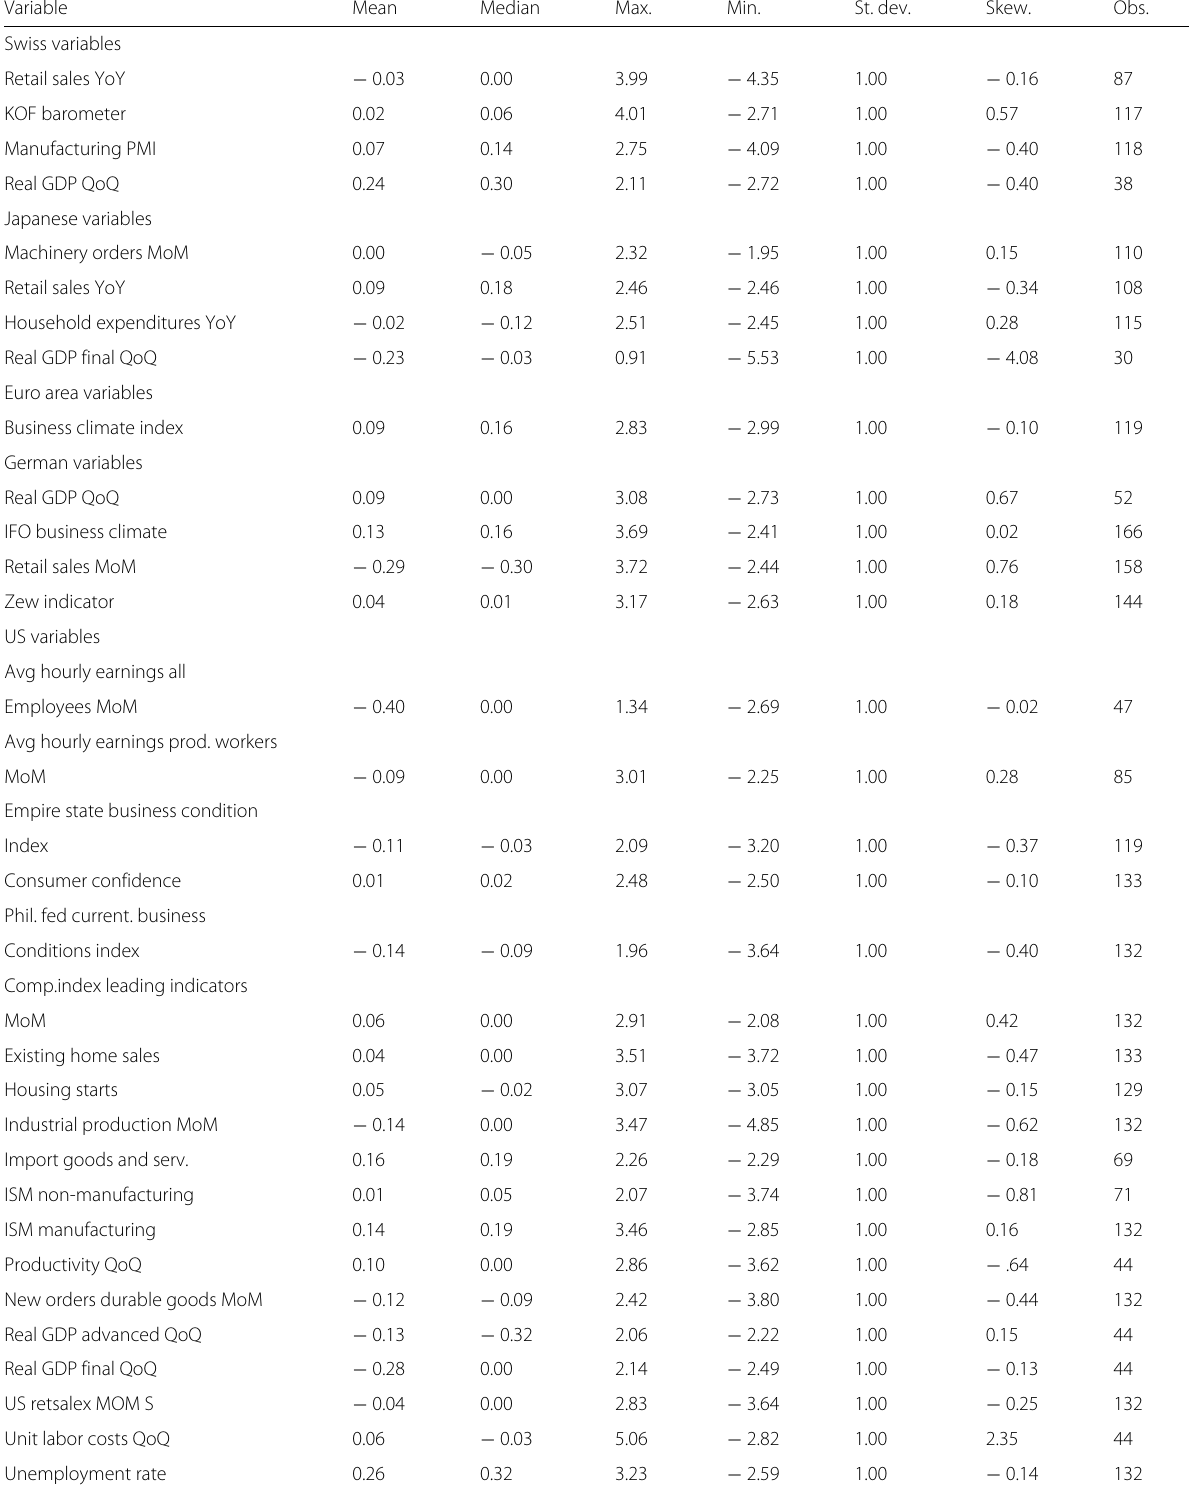
Table A4 Descriptive statistics of selected